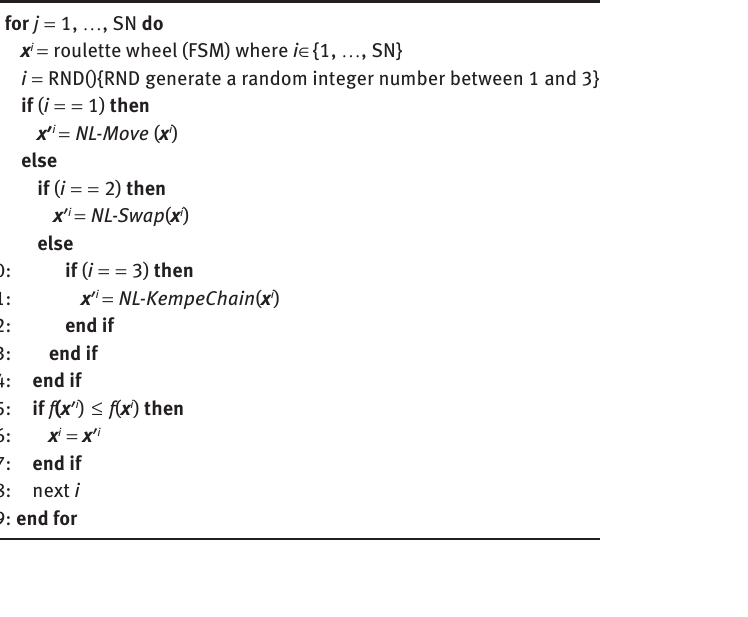
Algorithm 4: Onlooker Bee Phase